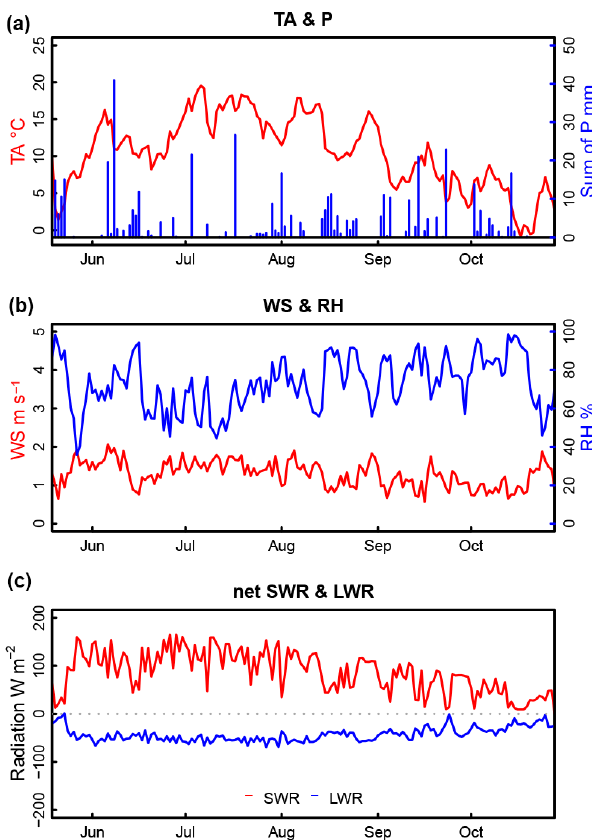
Figure 3. Meteorological input data aggregated to daily values for the Flüela site. Air temperature (TA) and precipitation are shown in the upper panel, wind speed (WS) and relative humidity (RH) in the middle and net short-wave (SWR) and net long-wave (LWR) radiation in the bottom panel. Measurements were obtained from the stations WT (TA, WS, RH) and DAV (SWR, LWR, P ).